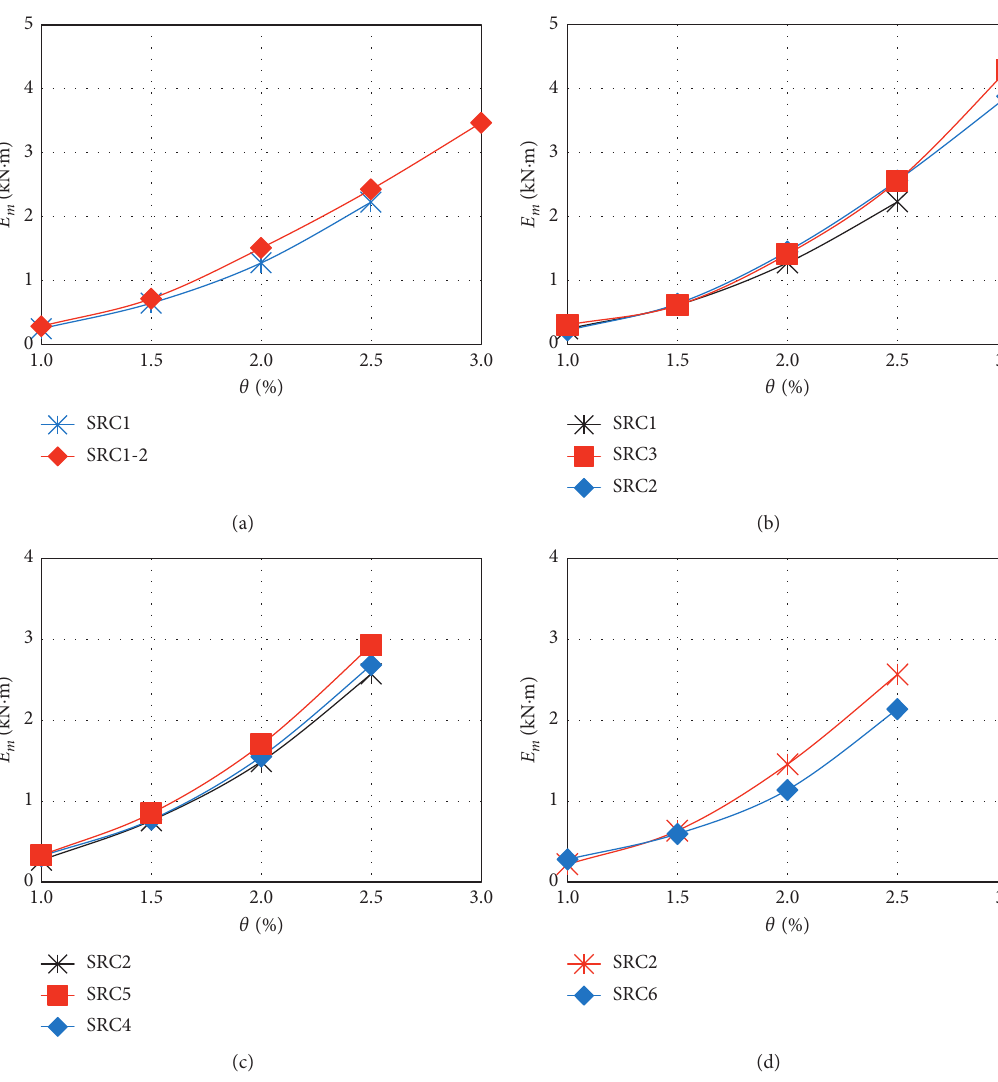
− θ ) of specimens. Effect of (a) cyclic loading number on E m